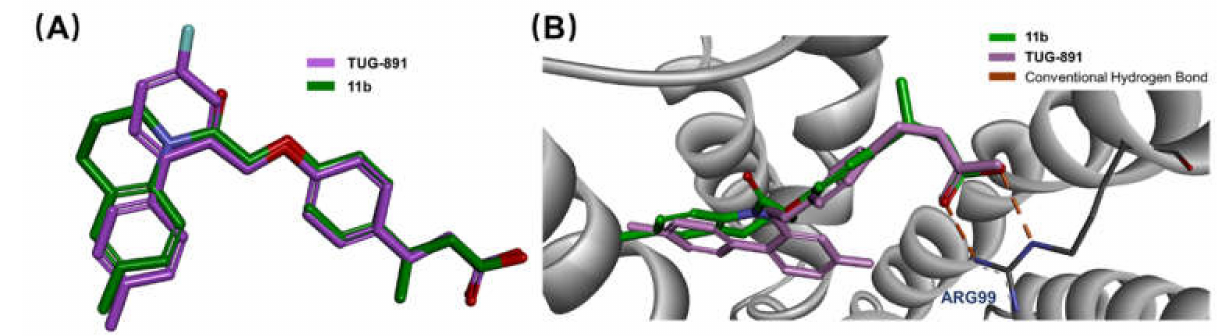
Figure 5. ( A ) The conformation overlap between TUG-891 and compound 11b . ( B ) Docking of compound 11b and TUG-891 inside of a homology GPR120